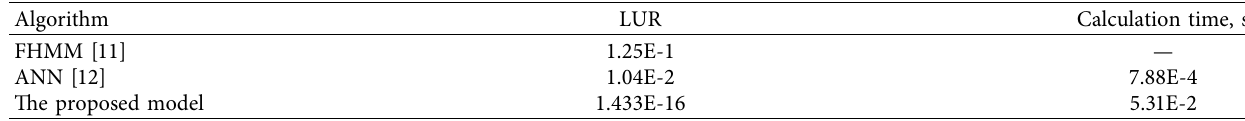
Table 9: Comparison of identification results of different models.